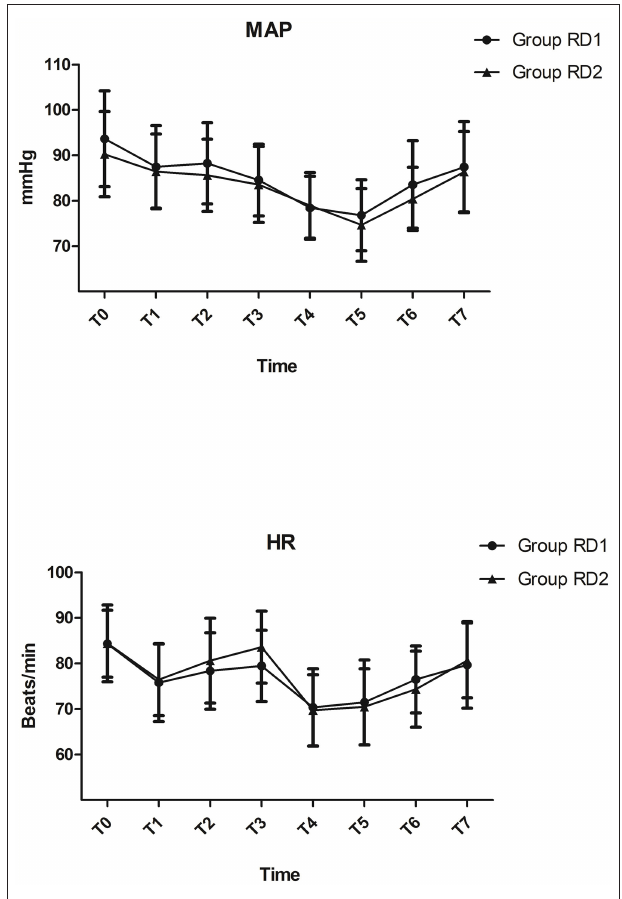
FIGURE 2 | Intraoperative